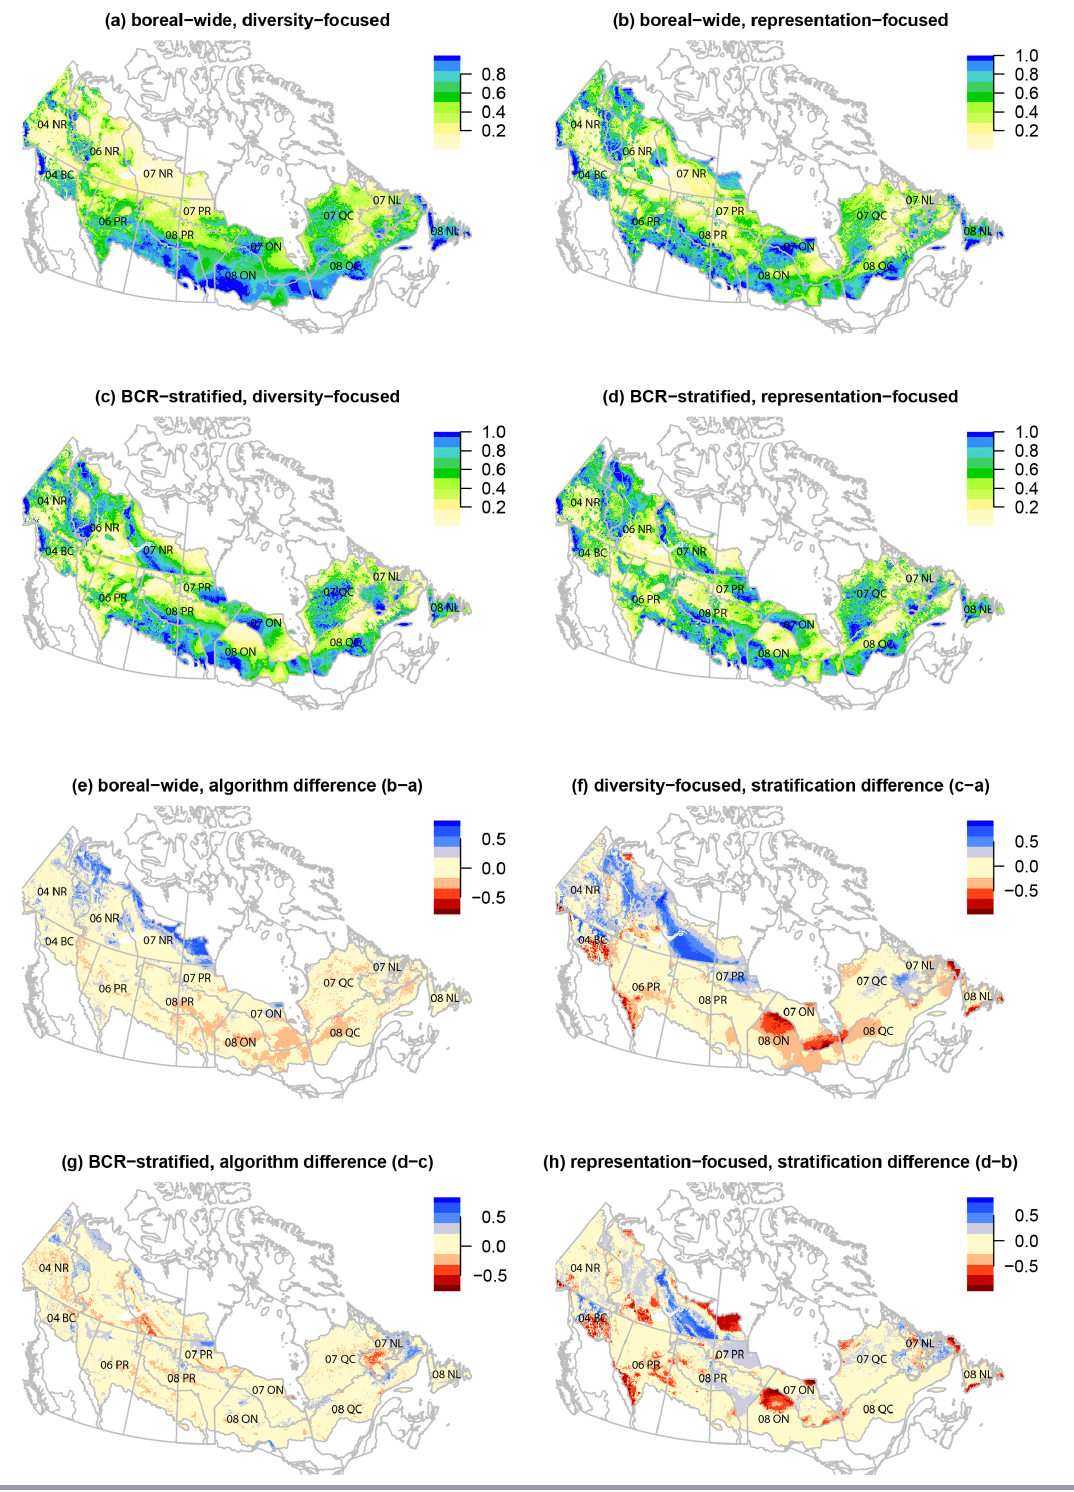
Fig. 5 . Priority rankings (a-d) and differences among them (e-h), based on four baseline scenarios: boreal-wide, diversity-focused (scenario 65), and representation-focused (scenario 1); and bird conservation subregion-stratified diversity-focused (scenario 67) and representation-focused (scenario 3). For panels a-d, highest Zonation ranks are in dark blue; lowest ranks are in yellow. For panels e-h, blue indicates higher rank than the comparison scenario; red indicates lower rank. BCR = bird conservation